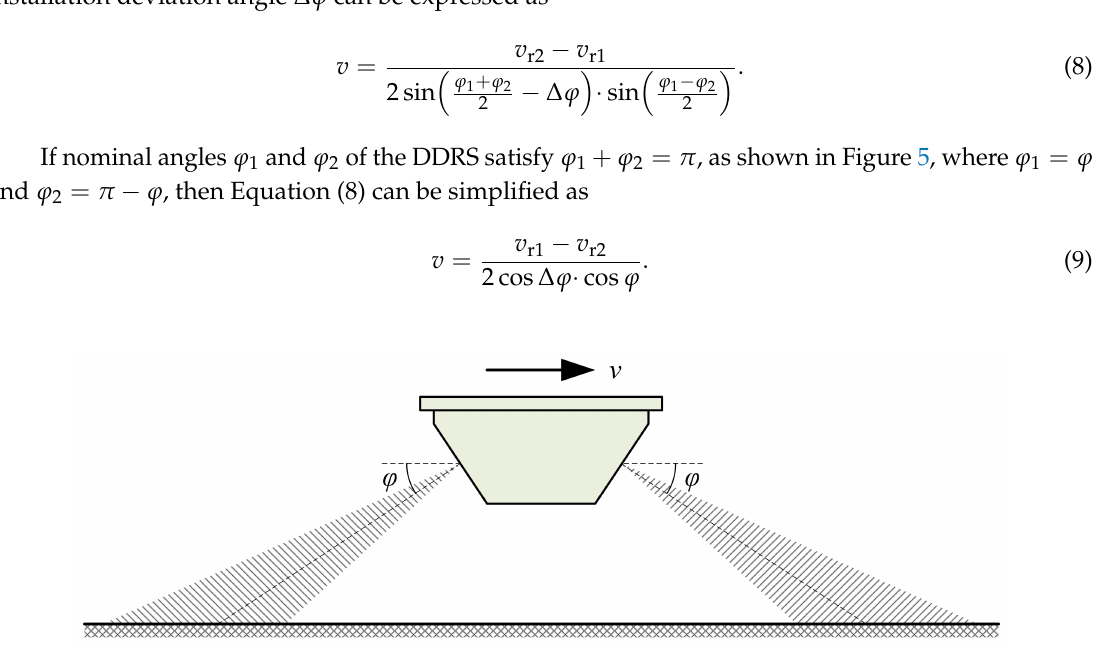
Figure 5. The simplified schematic diagram of the proposed symmetrical structure form of the